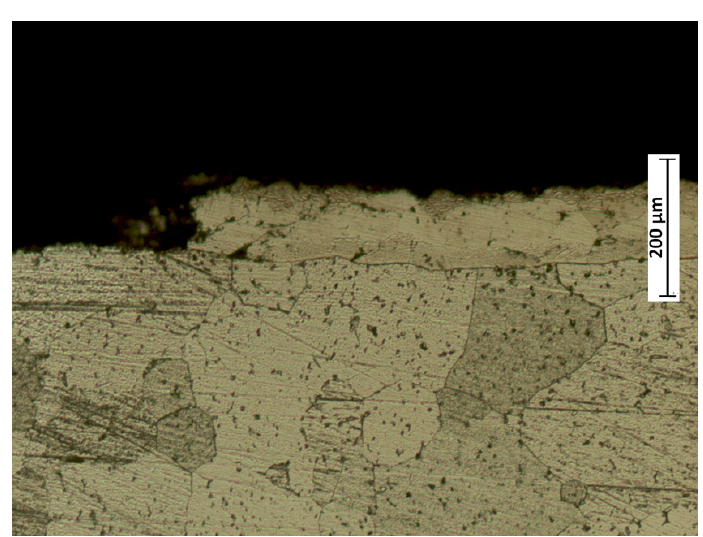
Figure 9. Microstructures after chemical etching of molybdenum powder after sintering at 1900 °C under 70 MPa pressure for 30 min showing the carbide layer on the surface.